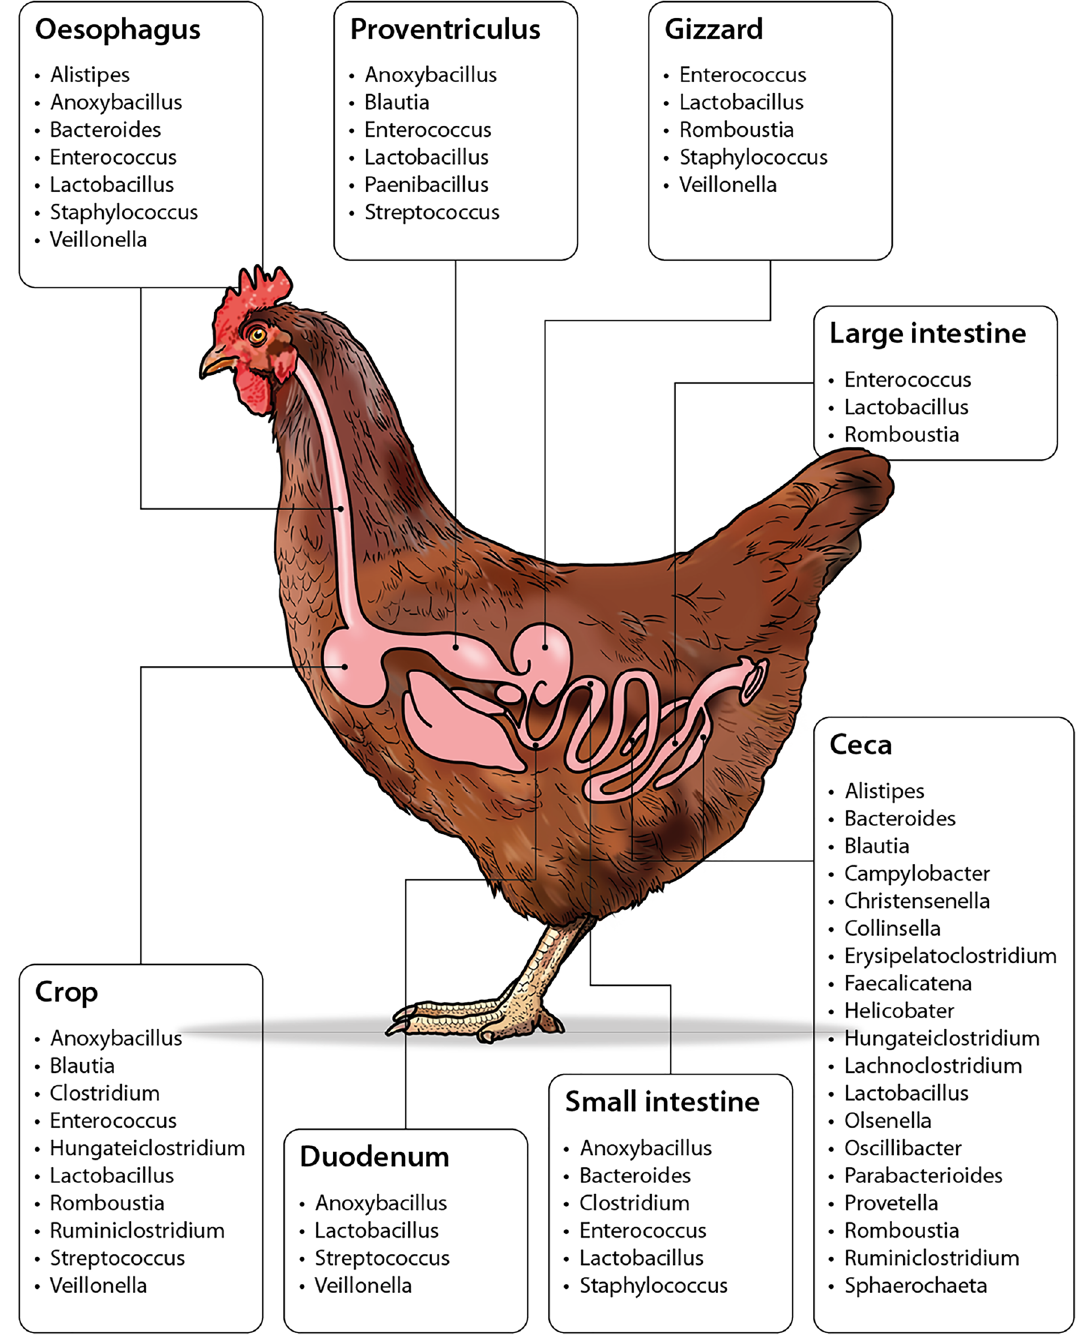
Figure 3. Bacteria genera identified across the entire gut segments of layer chicken fed on black soldier fly larvae